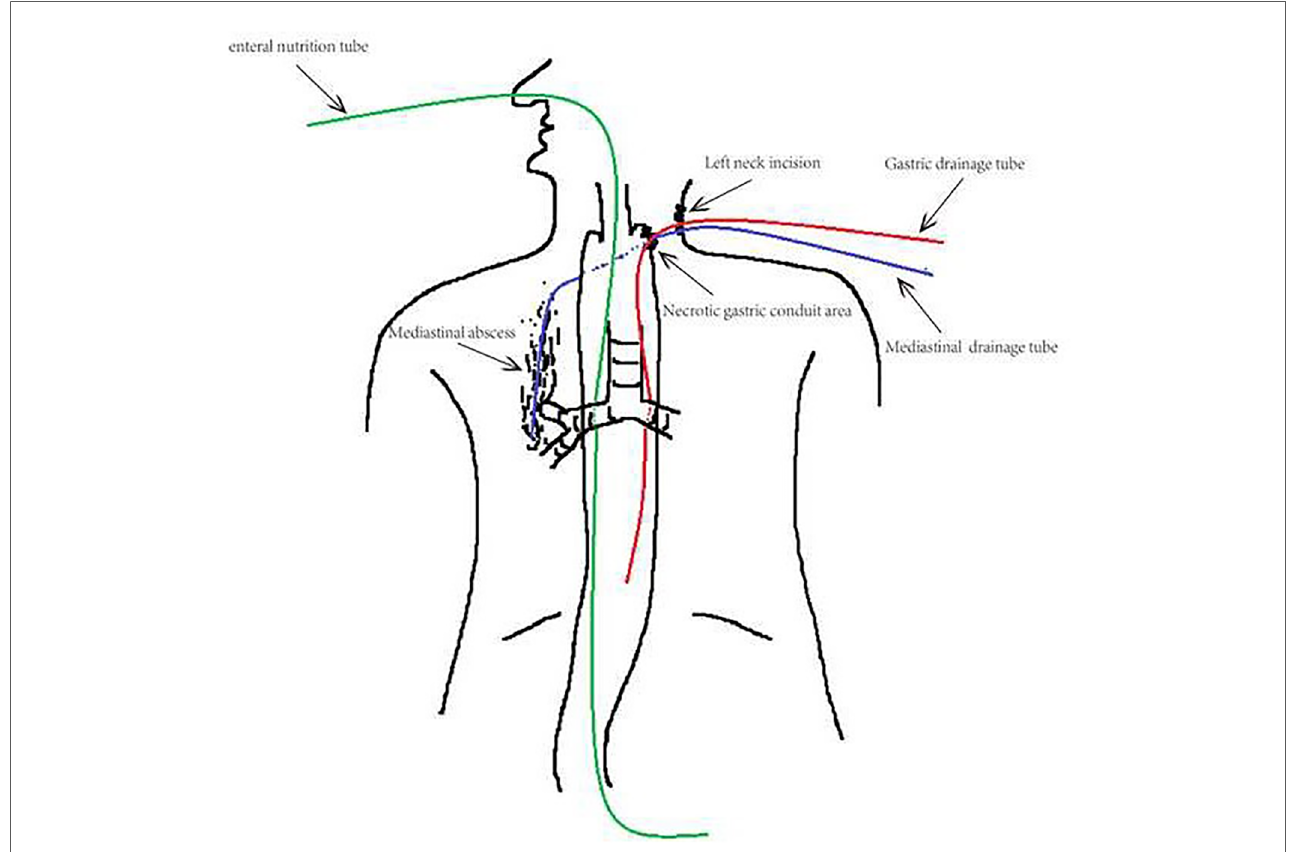
FIGURE 2 Insertion of drainage tube. Feeding tube was inserted into duodenum intraoperation via nose to afford enteral nutrition. Gastric and mediastinal drainage tubes were along primary neck incision, and both continuously decompressed. The bottom of mediastinal drainage tube was obtuse and obstructed, had 4 side holes, and 1 cm distant from the right inferior